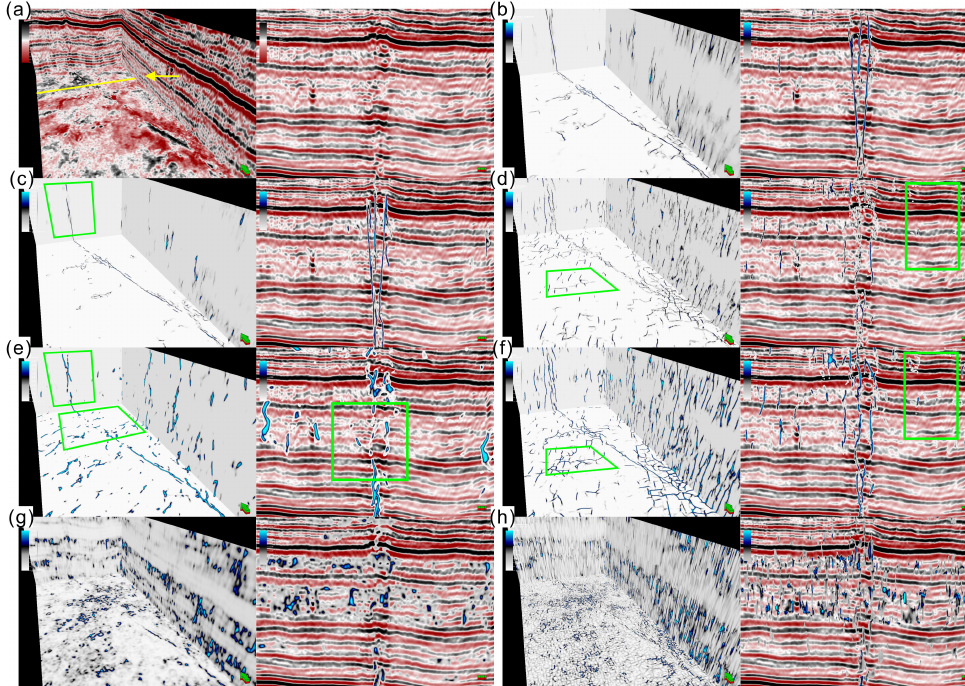
Figure 10. Fault recognition results of work area A. ( a ) Field seismic data. The yellow line represents the position of the detailed slice. ( b ) Detected faults by our structural data augmentation method. ( c ) Detected faults by Net_manual [62]. ( d ) Detected faults by Net_transfer [118]. ( e ) Detected faults by Net_syn_Wu [68]. ( f ) Detected faults by Net_syn_our. ( g ) Detected faults by Coherence [19]. ( h ) Detected faults by Curvature